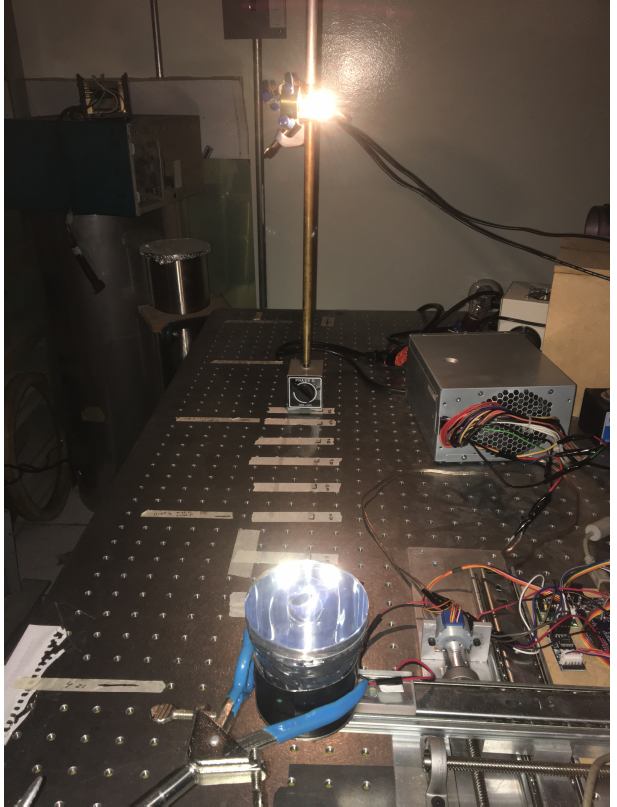
Figure 6. Experimental setup showing the lamp, the marks on the table, the system and XY position- ing system together with the